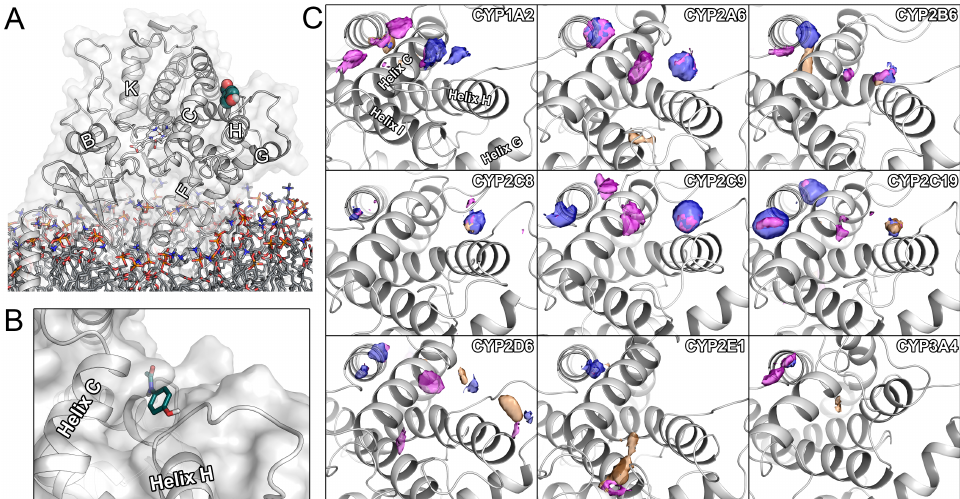
Figure 1. Structural overview and cosolvent densities. ( A ) Structure of membrane-anchored CYP2D6 with a ligand bound to the H1 site (shown as spheres). For orientation, helices have been denoted with letters. ( B ) Close-up view of the H1 allosteric site in CYP2D6 with bound ligand acetaminophen. ( C ) Probe densities obtained from cosolvent MD simulations. Pink densities correspond to pyridine, blue ones to isopropanol, and orange ones to acetonitrile. The probe densities are shown at an isolevel of 15 σ above the basal level of